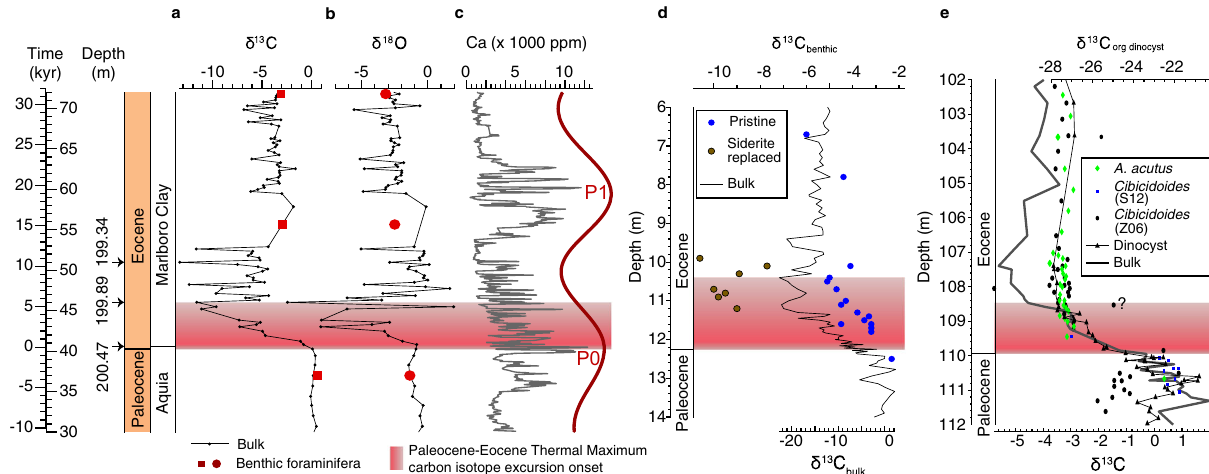
Fig.3| Paleocene-EoceneThermalMaximum(PETM)carbonisotopeexcursion (CIE)onsetonthemid-AtlanticCoastalPlain.a Tuned δ 13 CvaluesoftheHowards Tract (HT) cores. b Tuned δ 18 O values of the HT cores. c Tuned calcium content generated from X-ray fl uorescence (XRF) scans (gray line) and fi ltered precession (P) cycles (red line, detailed in Fig. 2h) of the HT cores. d δ 13 C values of the